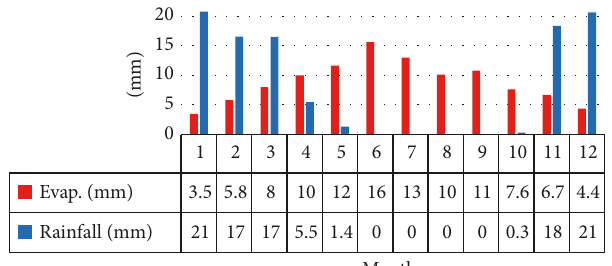
Figure 1: Average monthly rainfall and evaporation rates in the study area